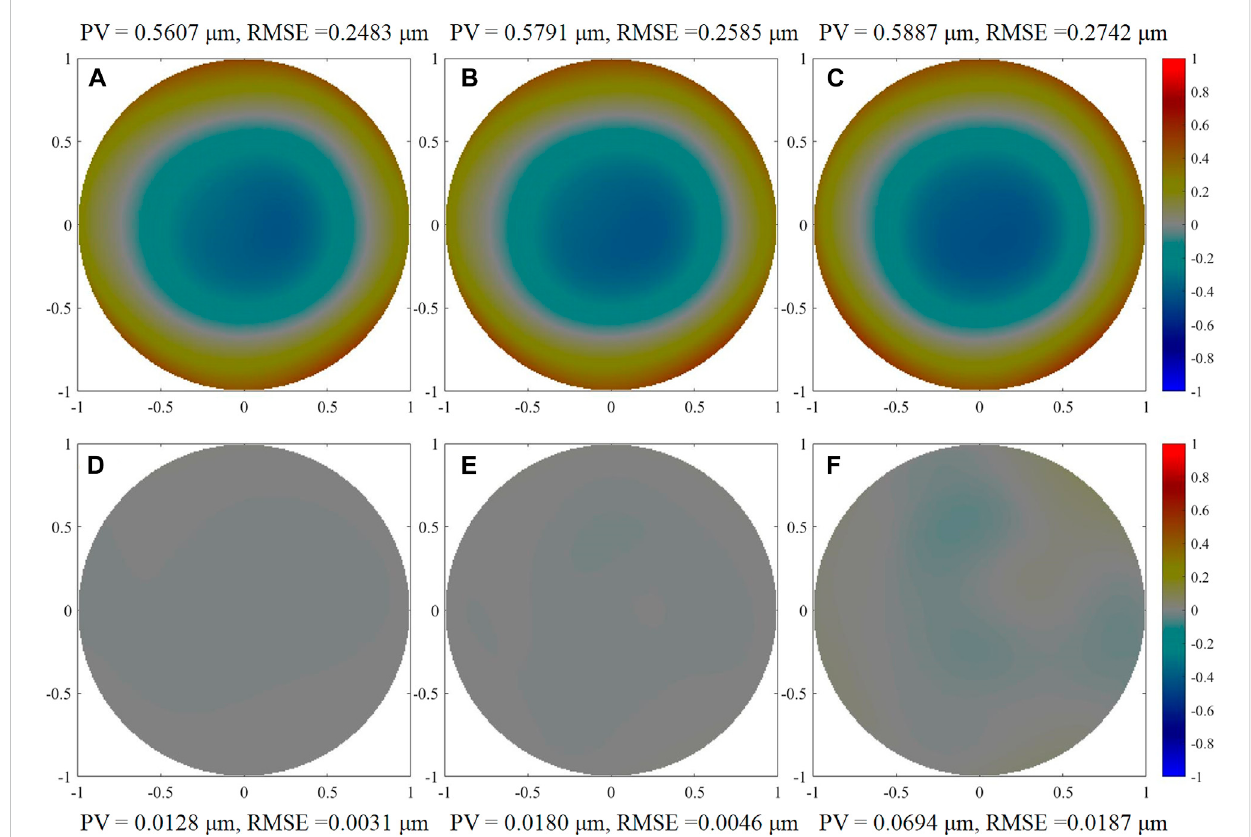
FIGURE 10 The residual error of wavefront measured by the traditional method (A – C) and p-SHWFS (D – F) under different noise levels.